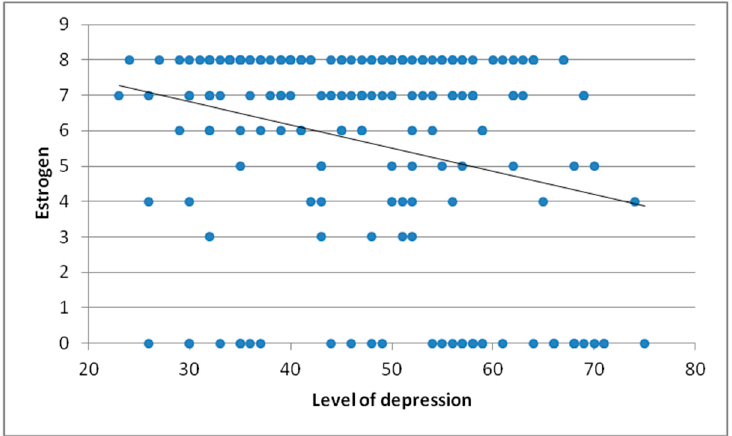
Figure 5. Correlation between level of depression and estrogen.